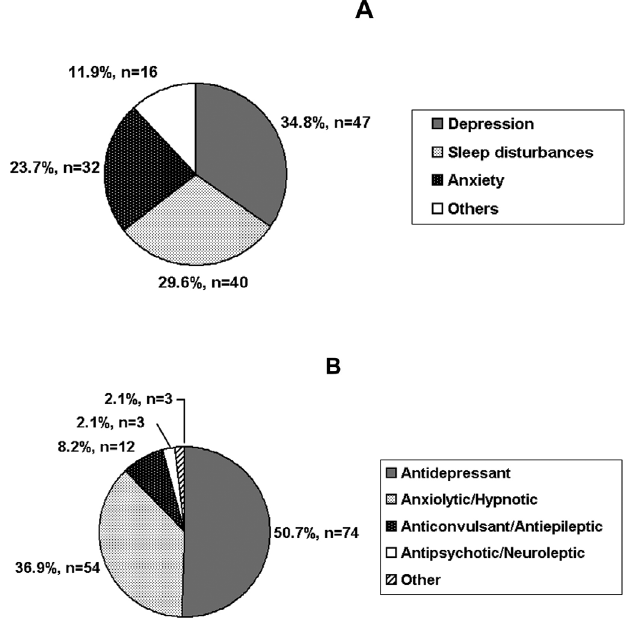
FIGURE 1 - The predominant central nervous system diseases diagnosed and reported* in the elderly sample population (n=135) (A). Pharmacological classes of drugs acting in the CNS, used by the elderly sample population (n=146) (B). * Each patient may present with more than one disease and use more than one